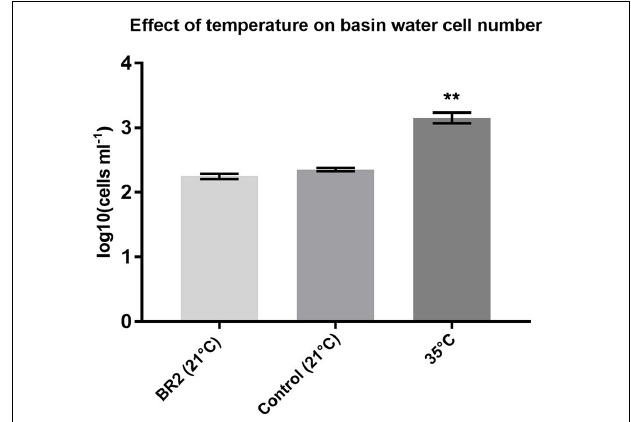
FIGURE 4 | Effect of 24-h temperature increase on basin water cell number. Error bars represent standard error of the mean. Groups were compared using a non-parametric Kruskal–Wallis test. P -value = 0.0024, n = 4, ** p <